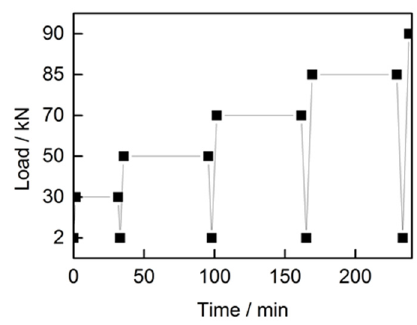
Figure 5. Stress-strain loading procedure of ACCC/HW.